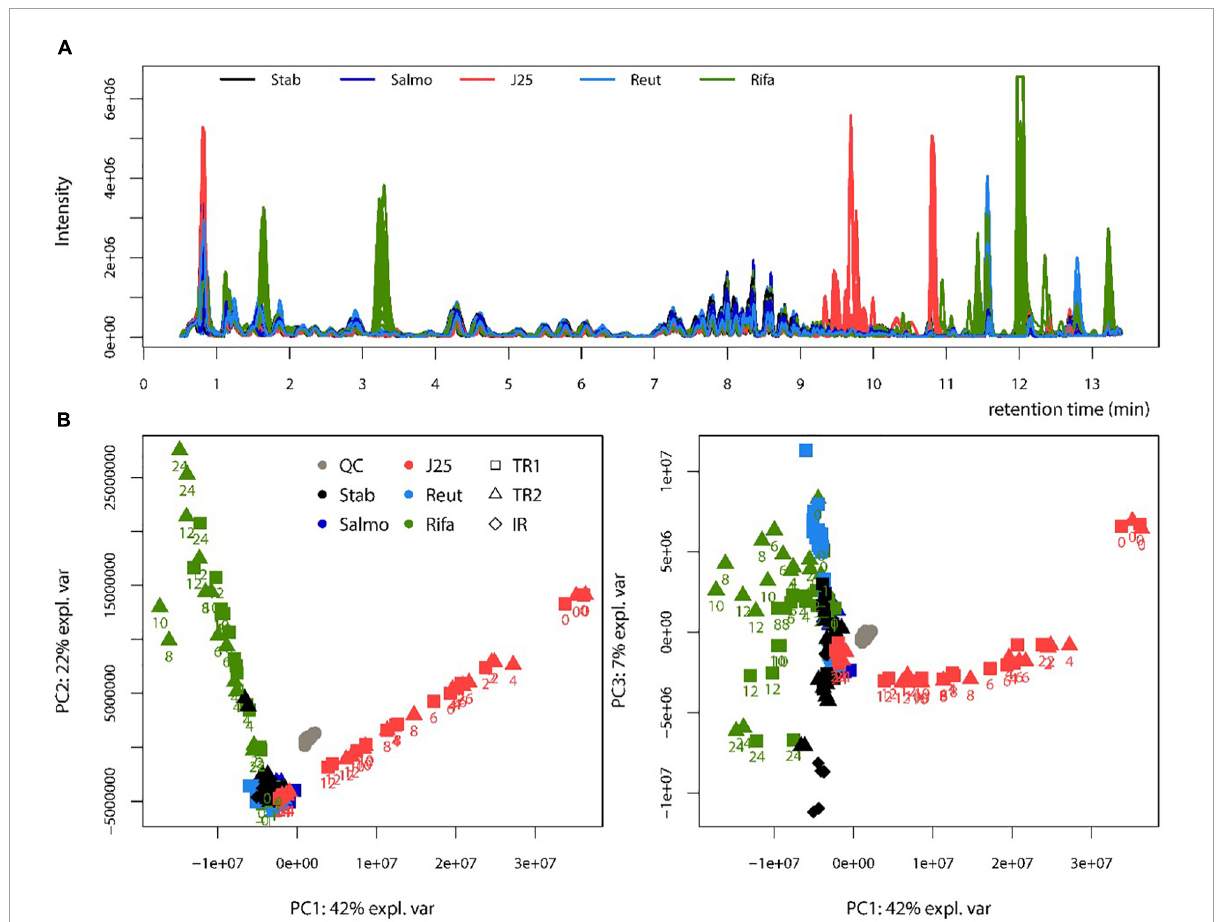
FIGURE6 Metabolomic profiling of swine colonic microbiota in the PolyFermS model. (A) Base peak chromatograms obtained by LC-MS for each treatment. Stab: stabilization, Salmo: Salmonella Newport treatment, J25: Salmonella Newport + 0.4 mM MccJ25 treatment, Reut: Salmonella Newport + 4 mM reuterin treatment, Rifa: Salmonella Newport + 0.6 mM rifampicin treatment; (B) Score plot of the PCA obtained from LC-MS data (left: PC1 versus PC2, right: PC1 versus PC3). The reactors sampled (test reactors TR1 and TR2 and inoculum reactor IR) are shown with symbols. The collection times after Rifa and J25 treatments are written below the symbols. QC: control